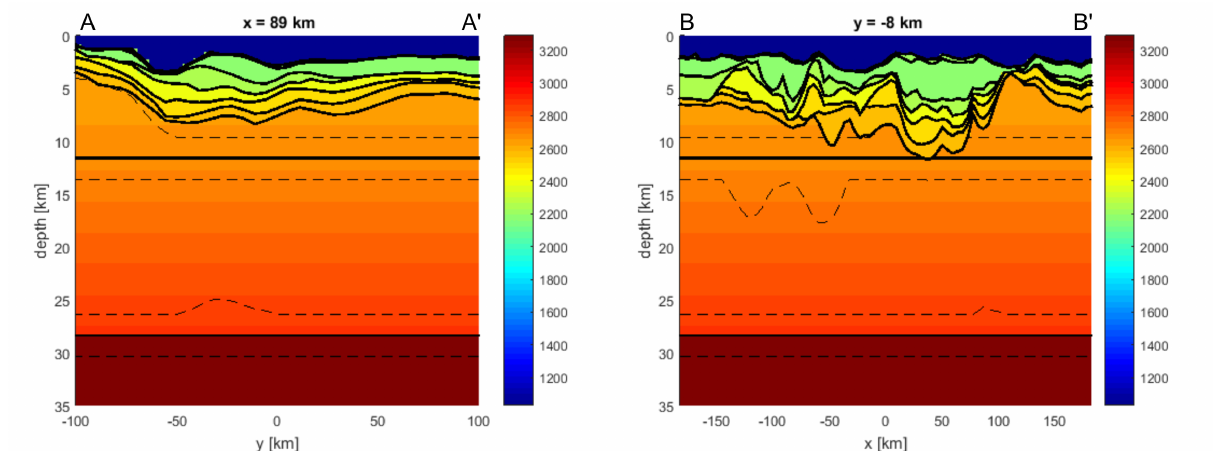
Figure 6. Example of two profiles (AA’ and BB’ in Figure 1) for Scenario 1 inversion:. Solid black lines represent discontinuity between different geological units, dashed lines represent uncertainty, colours represent density in kg/m 3